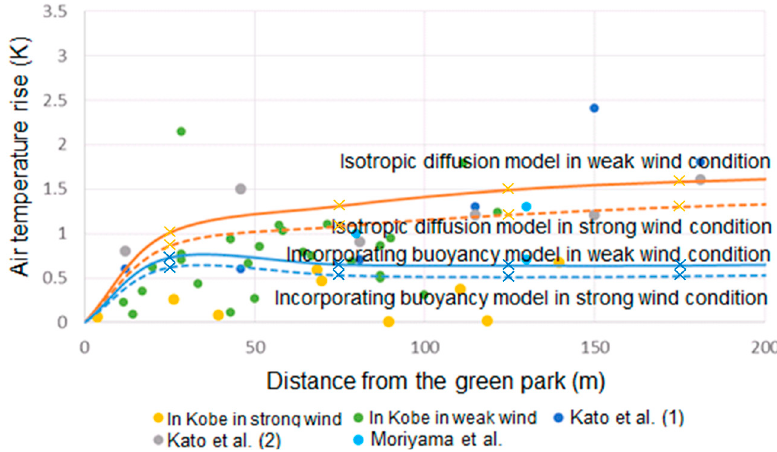
Figure 9. Distance from the green area and air temperature rise in several urban areas in the evening.